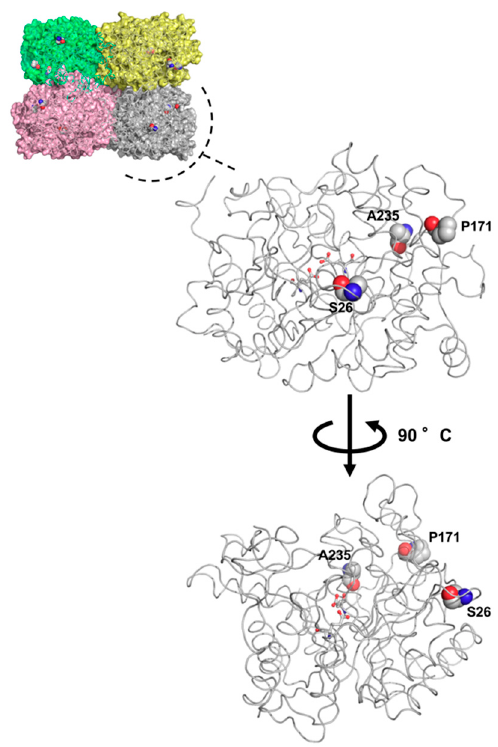
Figure 1. The aminoacid residues mutated in the Saccharolobus solfataricus ( Ss β -Gly) H7 enzyme. The position of S26, P171, and A235 residues (in spherical format) are shown on the tetrameric and monomeric 3D structures of Ss β -Gly, represented in ribbon format. Catalytic residues in the active site are highlighted in ball and stick format, and all atoms are colored by the CPK convention.